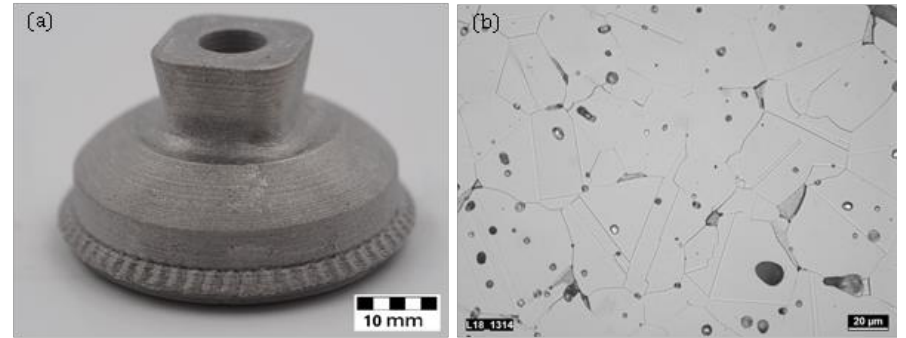
Figure 5. ( a ) CEM printed and sintered 316L part and using conventional MIM feedstock Catamold (BASF, Ludwigshafen, Germany) ( b ) optical microscopy of CEM printed 316L part showing microstructure and inclusions of carbon and foreign particles comparable to conventional manufactured MIM parts.